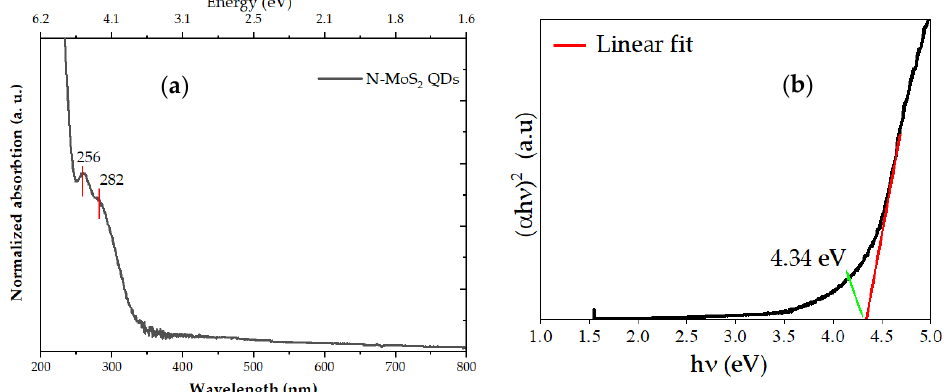
Figure 3. ( a ) Spectral absorbance of N-MoS 2 QDs synthesized by making use of Nd:YAG laser during cryogenic PLA synthesis process. ( b ) Corresponding Tauc plot indicating the optical band gap energy of N-MoS 2 QDs. Note that, in general, the doping N amount and the QDs size affect the bandgap of N-MoS 2 QDs. In fact, the band gap enlarges in favor of the smaller